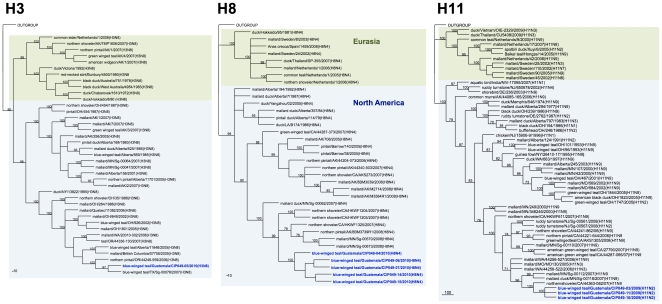
Phylogenetic trees for H3, H8 and H11 HA genes.Trees were generated in PAUP 4.0b10 using the Neighbor-Joining method with 1000 bootstrap replicates (bootstrap values above 70% are shown). Scale bar on the bottom-left indicates number of nucleotide substitutions per site.